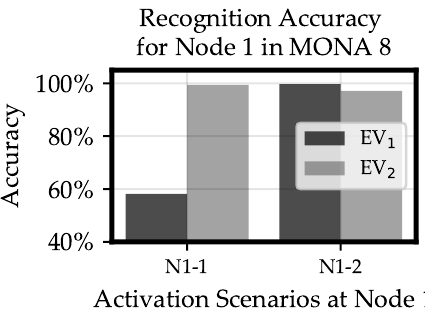
Figure 8. Recognition accuracies achieved by the best CNN found in hyper-parameter optimization in two activation scenarios at grid node N 1, which is the farthest node to the measurement point at N 10. The first scenario with relatively inaccurate classification of the first electric vehicle’s status contains an activation of electric vehicle 1 at node N 1 and no activation of electric vehicle 2 ( N 1 − 1), and the second one vice versa ( N 1 −